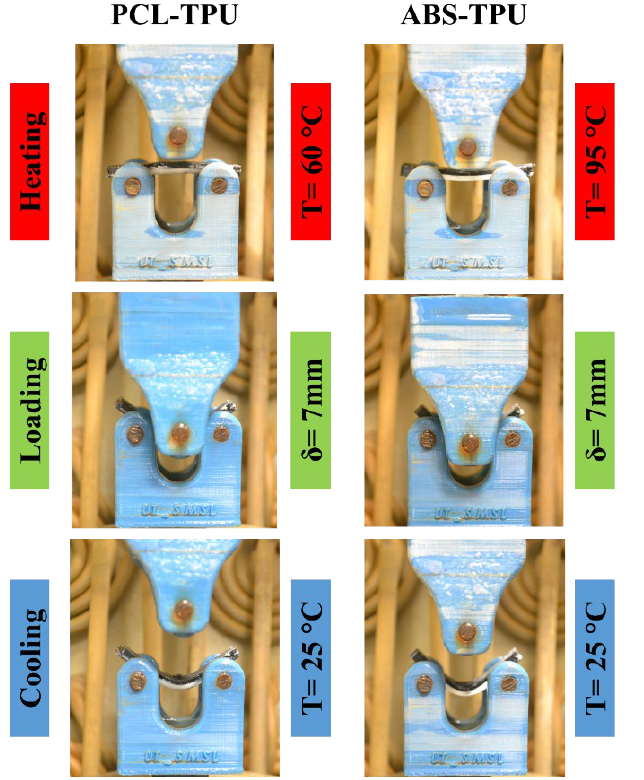
Figure 1. Steps and conditions of programming for two ABS–TPU and PCL–TPU composite struc- tures.